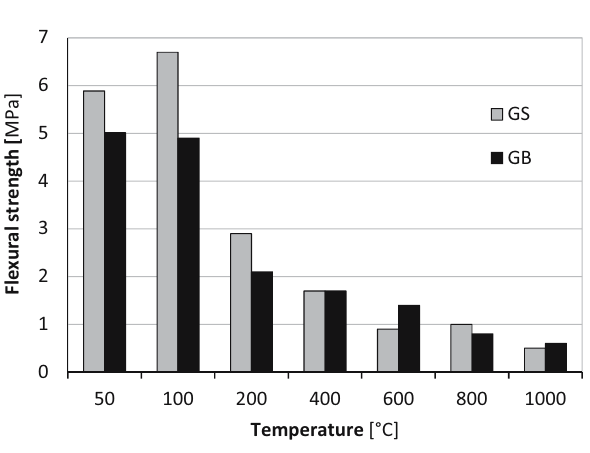
Figure 15: Flexural strength after